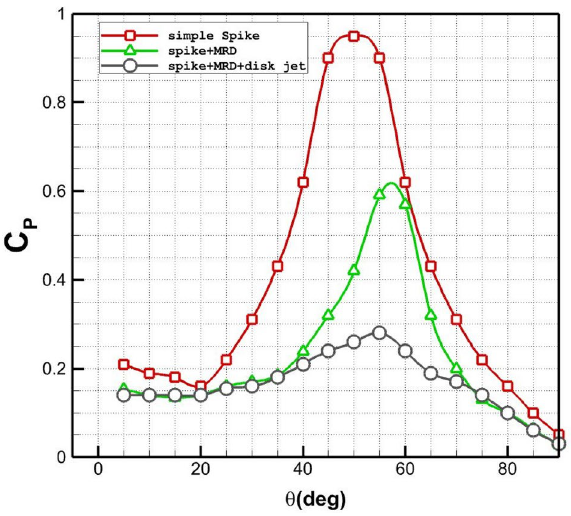
Figure 10. Influence of the different coolant injection systems on Pressure coefficient distribution.